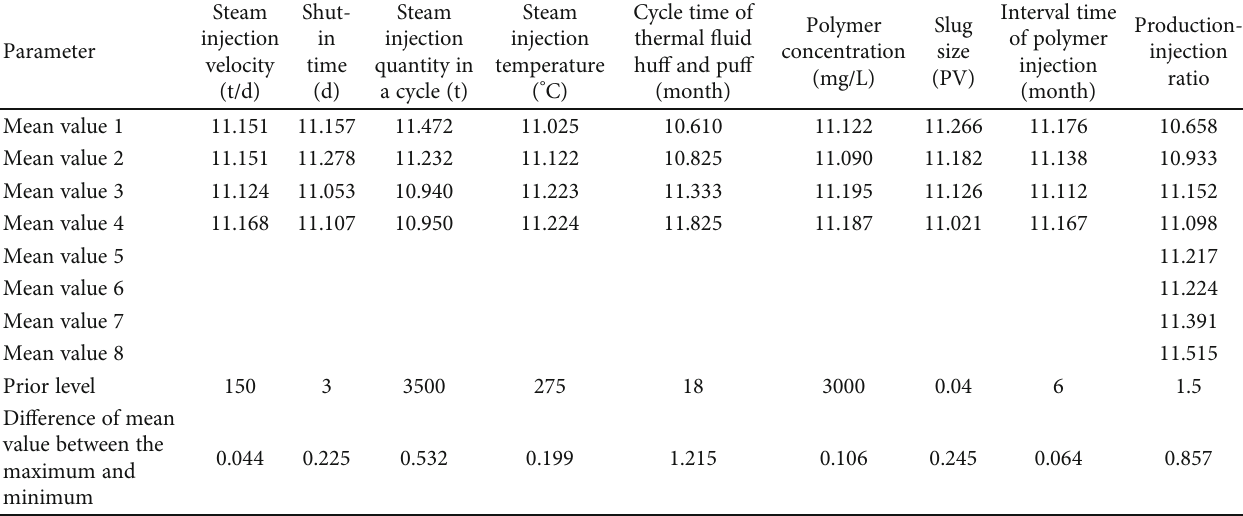
Table 10: Intuitive analysis table of the B6 well group with combined operation.